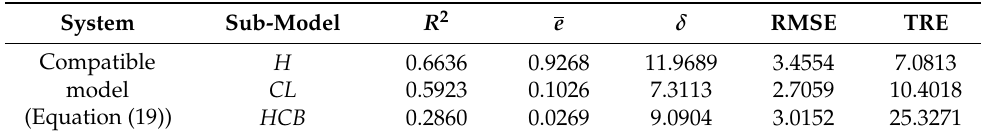
Table 4. Evaluation indices of (Equation (19)) ( H : total tree height; CL : crown length; HCB : height to live crown base; R 2 : coefficient of determination; e : bias; δ : bias variance; RMSE: root mean square error; TRE: total relative